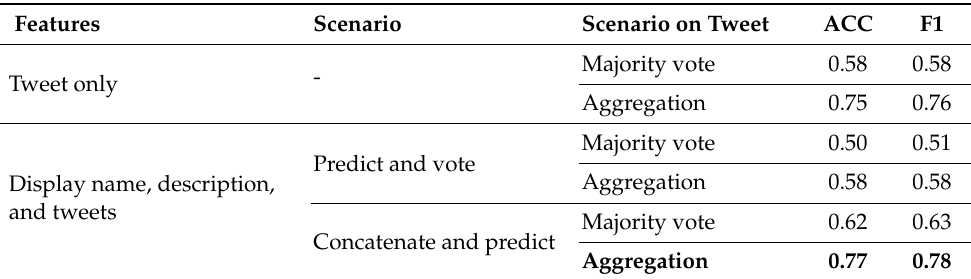
Table 4. Location prediction results by combining display name, user description, and user tweets. Two scenarios were applied in creating the predictions: the predict and vote and the concatenate and predict.